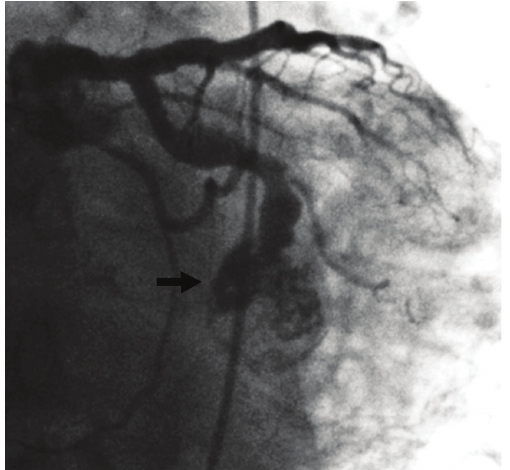
Figure 1: Subtotal thrombus occlusion of the left circumflex coro- nary artery aneurysm with blood flow into the aneurysm (arrow).